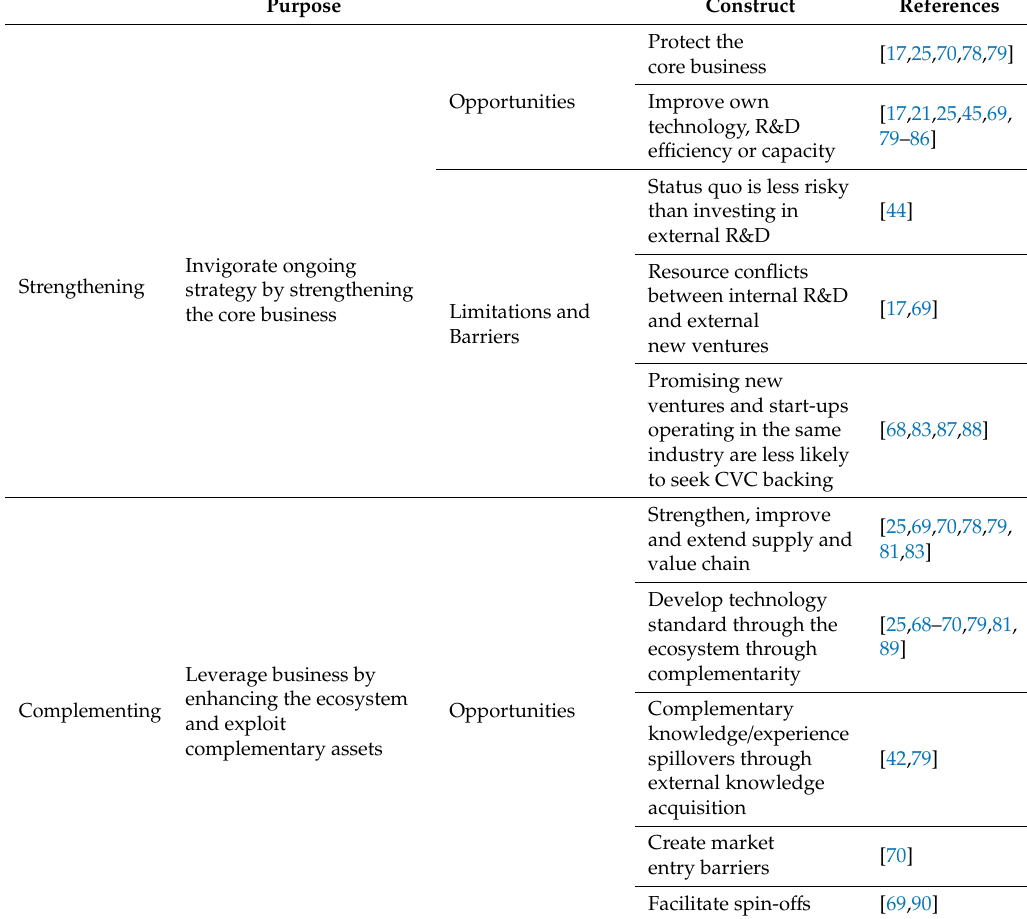
Table 1. Strategic Objectives of Corporate Venture